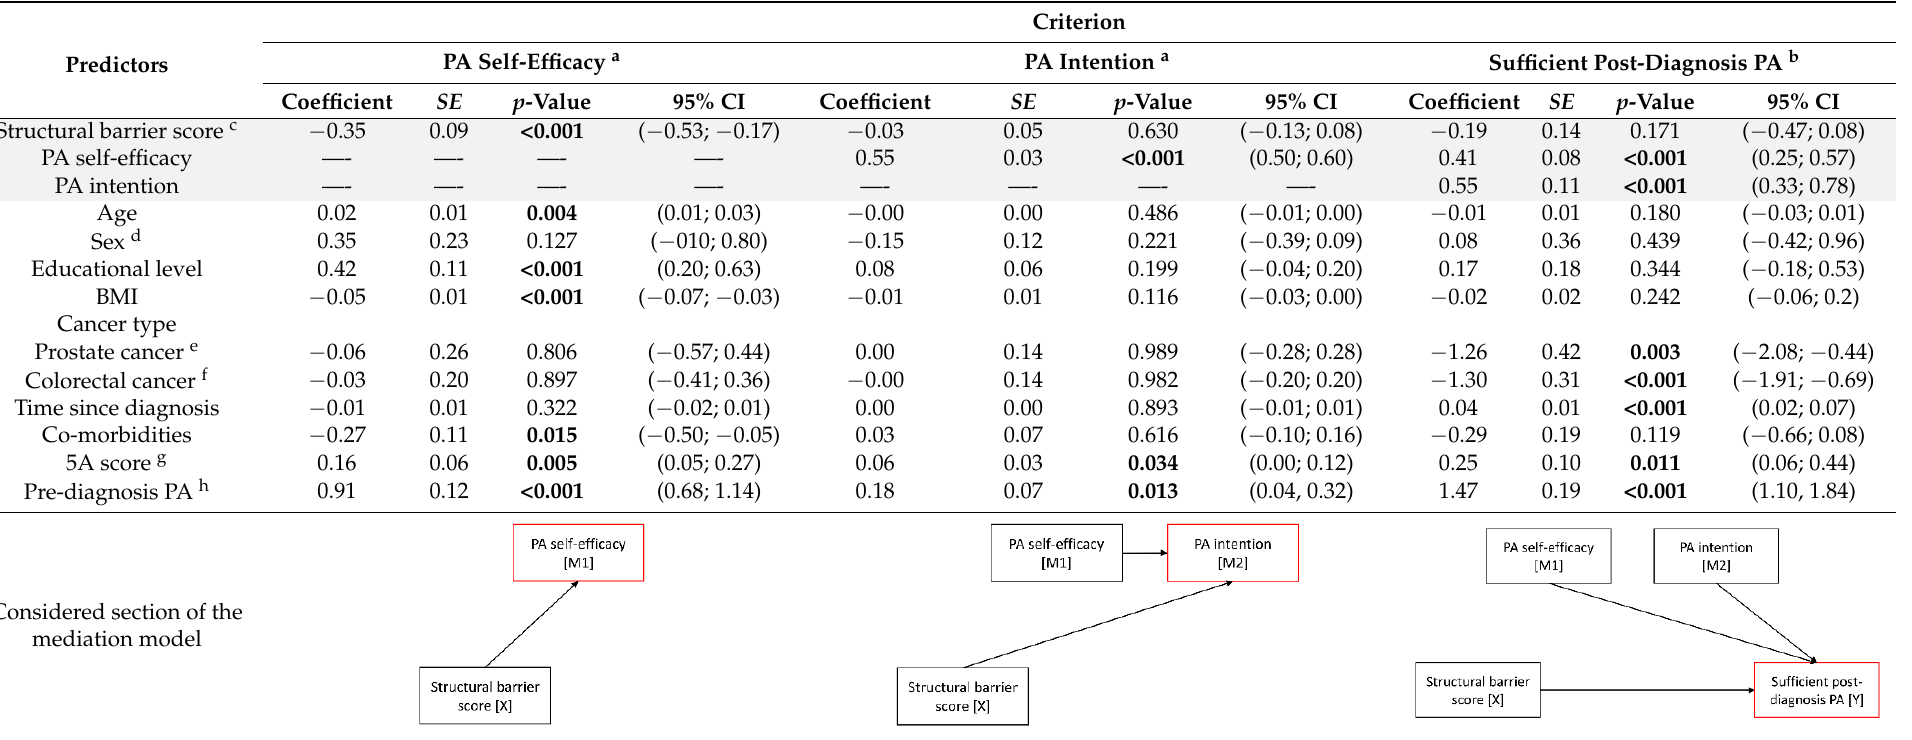
Table 2. Regression analyses on associations of structural barriers, physical activity self-efficacy, physical activity intention, and sufficient post-diagnosis physical activity within the mediation model.